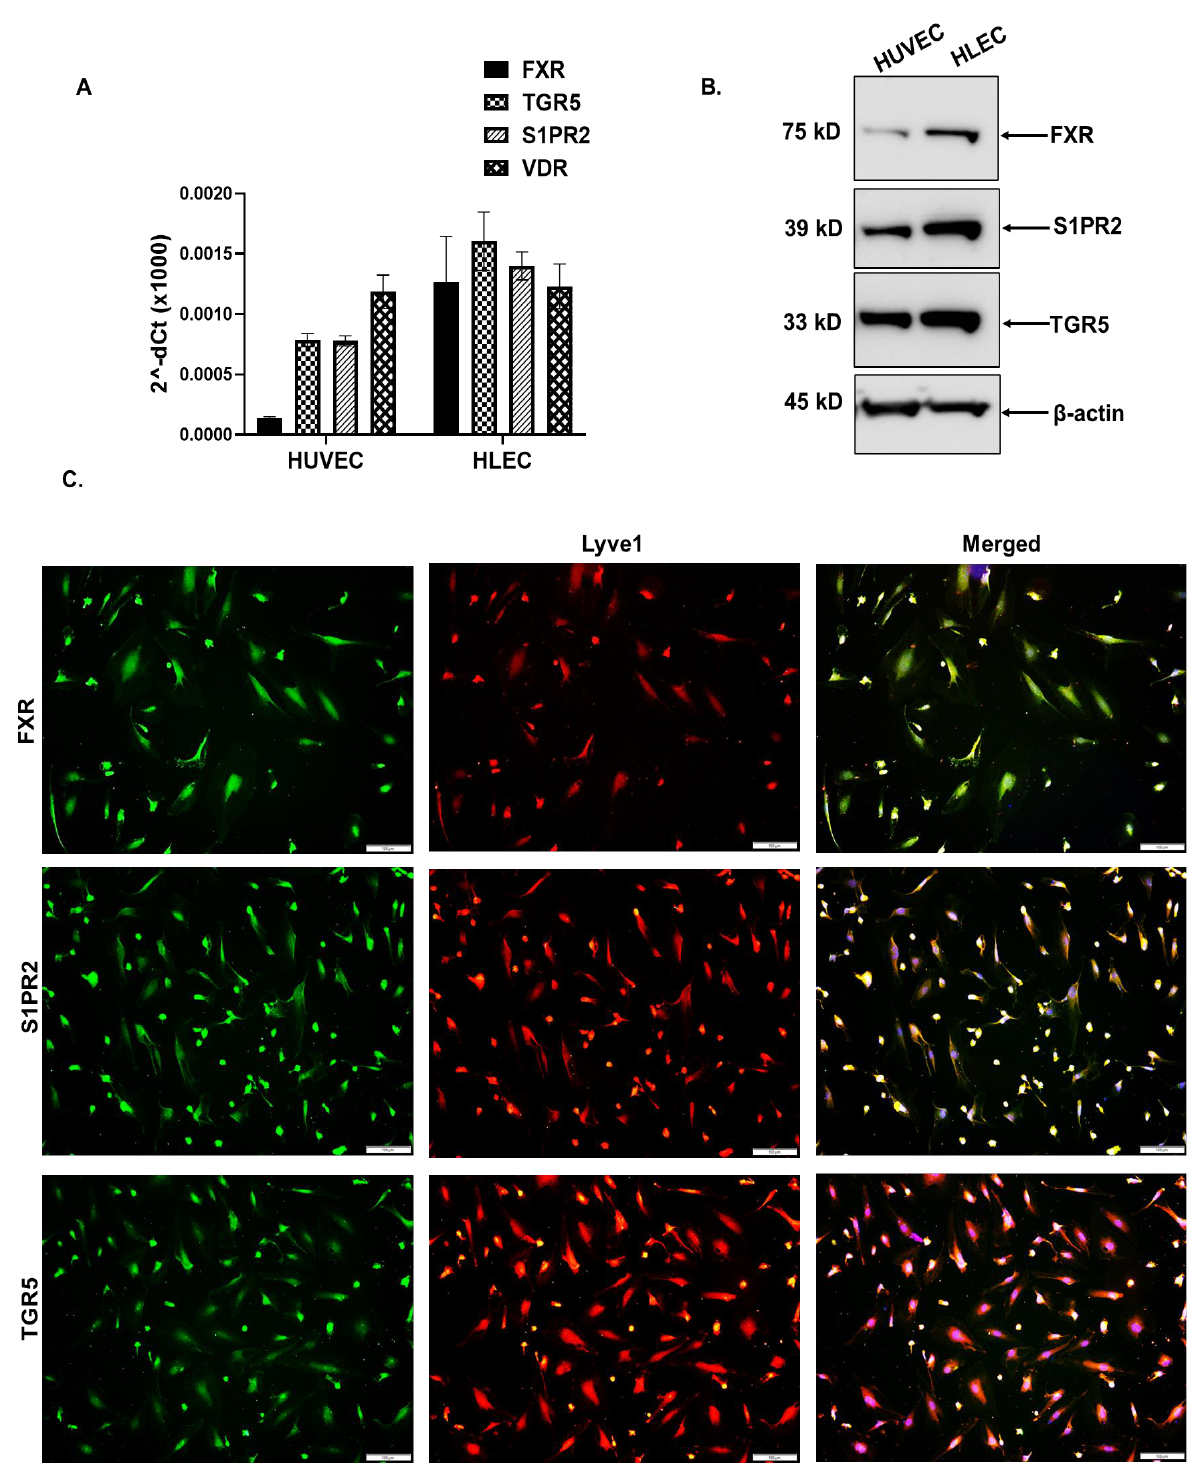
Figure 3. HLECs express the BA receptors FXR, S1PR2, TGR5, and VDR. ( A ) The basal level mRNA expression of the BA receptors, FXR, S1PR2, TGR5, and VDR were measured by qRT-PCR and the data were presented at 2 − dCt . ( B , C ) The protein level expression was measured by Western blot ( B ) and immunofluorescence ( C ) with the specific antibodies. HLECs were stained with Lyve-1 (red) in immunofluorescence. Values represent mean ± SD, n = 3. Scale bar is 100 μm.